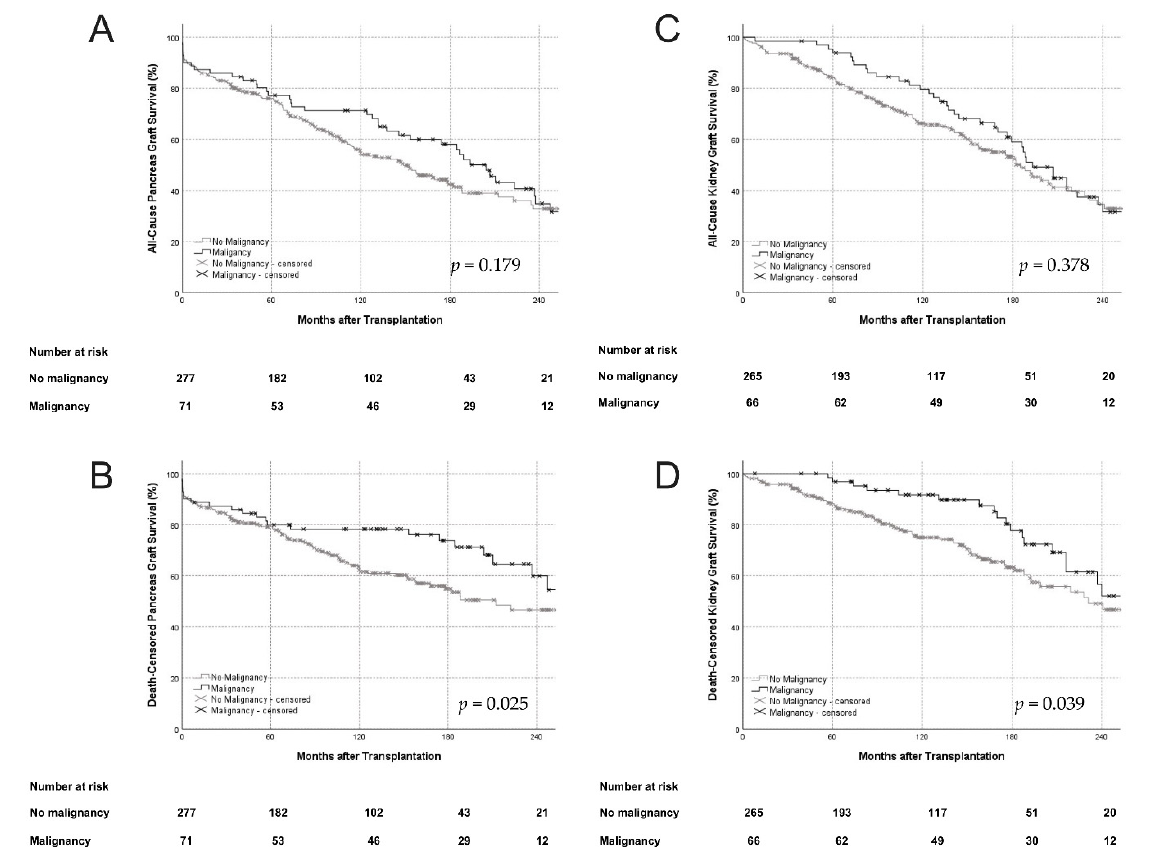
Figure 3. All-cause ( A , C ) and death censored ( B , D ) pancreas and kidney graft survival. While all-cause pancreas and kidney graft survival were similar between groups, death censored pancreas and kidney graft survival were significantly superior in patients with PTMs. PTMs, post-transplant malignancies.